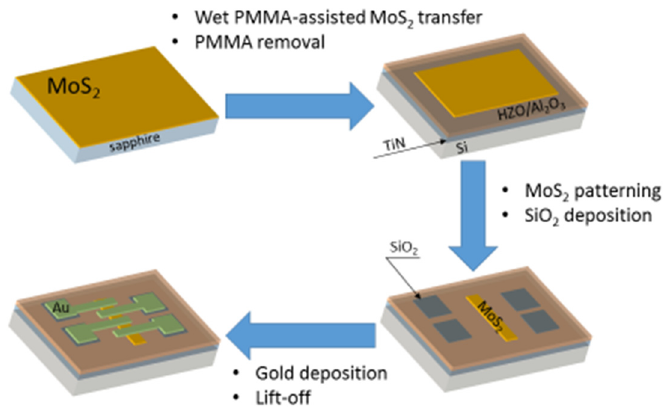
Figure 1. The process flow schematic of FET structure fabrication.